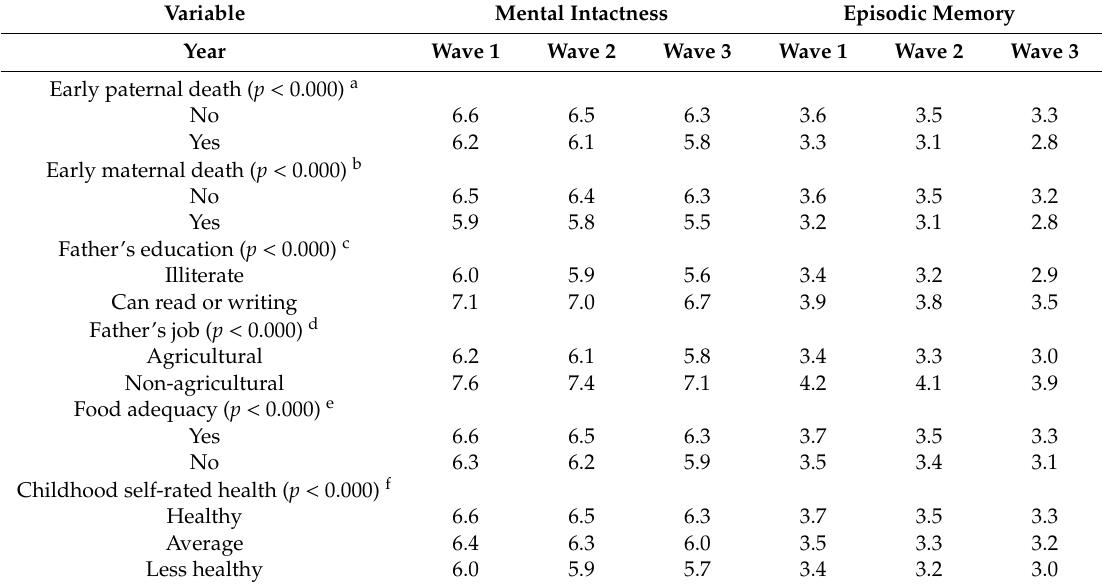
Table 2. Mean scores of cognitive function (2011–2015) by early-life conditions. Variable Mental Intactness Episodic Memory Year Wave 1 Wave 2 Wave 3 Wave 1 Wave 2 Wave